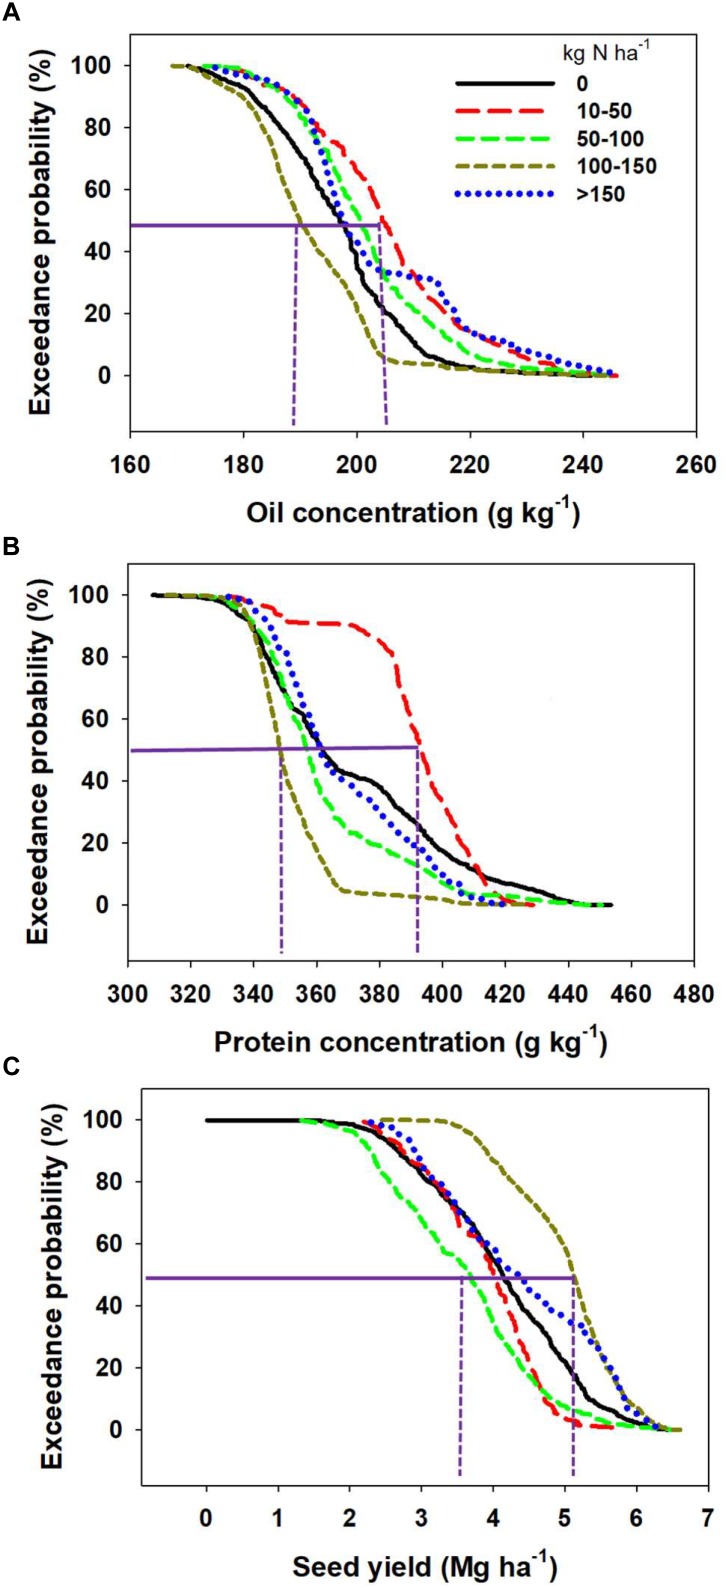
Exceedance probabilities for oil concentration (A), protein concentration (B), and seed yield (C) of soybean at different N rate. Exceedance probability here is defined as the probability (indicated in the y-axis) of obtaining oil, protein, or yield exceeding the indicated value (in the x-axis) for each fertilizer N rate category.